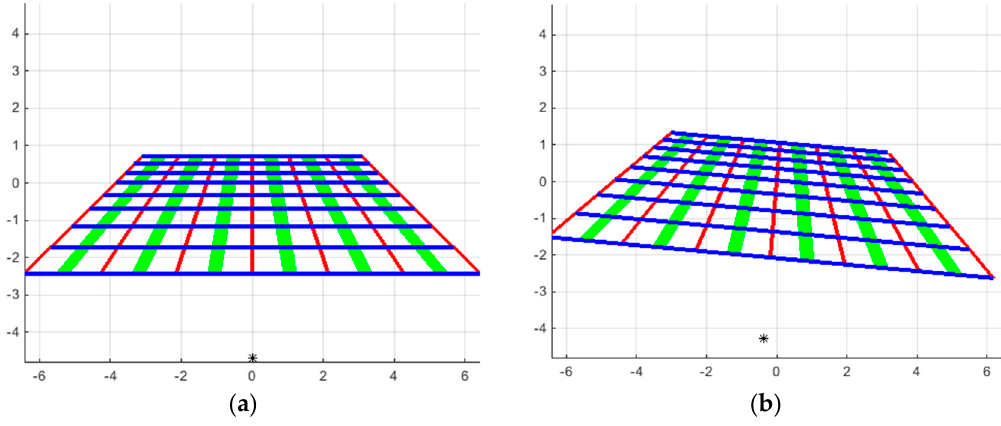
Figure 14. Geometric imaging projections of a Region Of Interest (ROI) for the SVS4050CFLGEA sensor with two different settings at ( X 0 , Y 0 , Z 0 ) ≡ (0,2,0) m: ( a ) with ( α , β , θ ) ≡ (20°,0°,0°); ( b ) with ( α , β , θ ) ≡ (20°,0°,+5°).